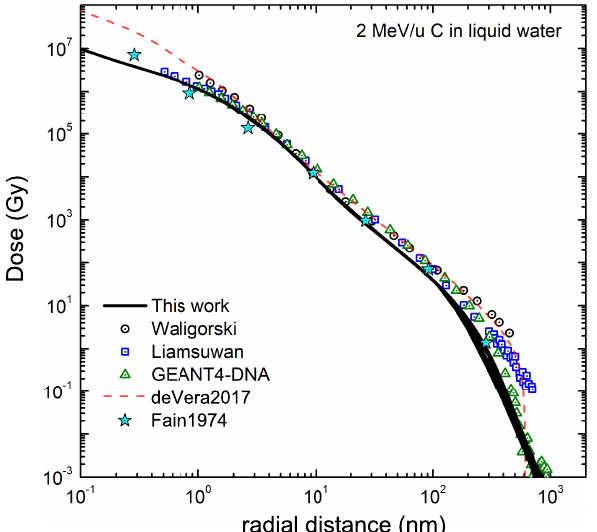
Figure 11. Dose deposited by 2 MeV/u carbon ions in liquid water, as a function of the radial distance from the ion path. Our simulation results are shown by a solid black line, corresponding to the ab initio models for liquid water, both for elastic and inelastic collisions. Comparison with other simulations are presented: [152] (circles), [153] (squares) and [154] (triangles). The result of an analytical model for liquid water is also presented (dotted line) [150]. Stars are calculations from Ref. [151] (as they appear in Ref.